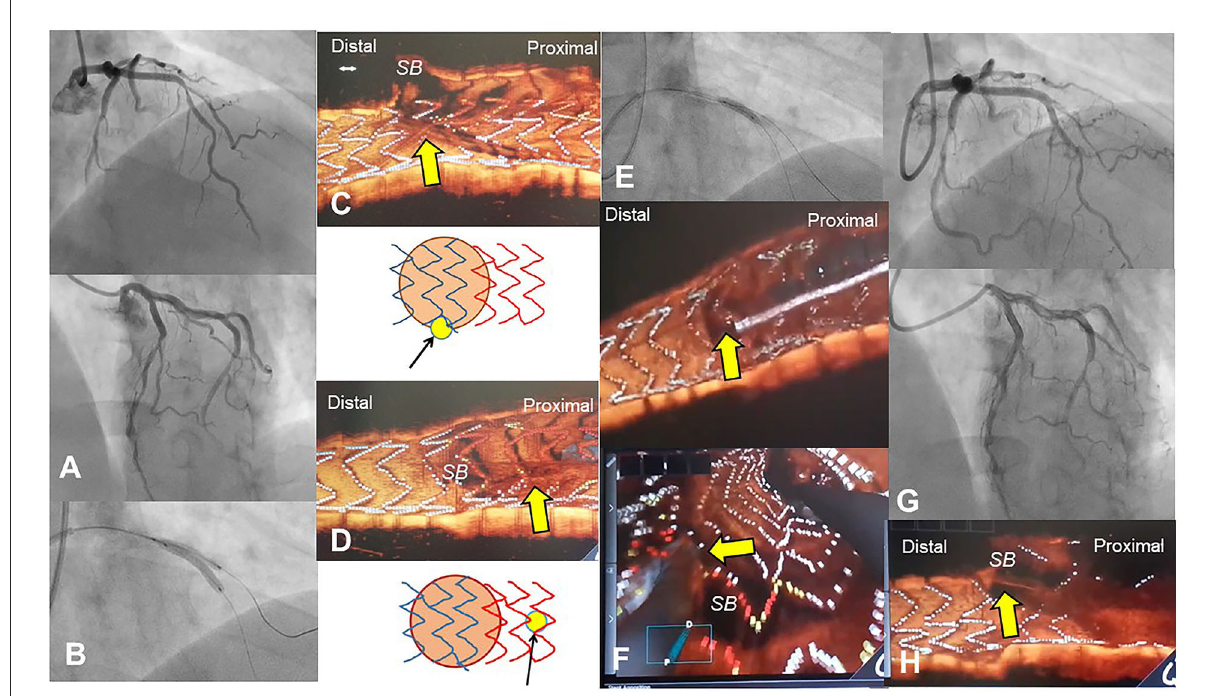
FIGURE3 Optimal guidewire recrossing using 3D optical coherence tomography (OCT) imaging after jailed balloon technique. A 55-year-old man with Medina 1-1-1 lesion in left anterior descending artery (LAD)-diagonal bifurcation (A) was treated with crossover stenting with jailed balloon technique that accompanied simultaneous dilation of a 2.75/18mm Ultimaster stent and a jailed 2.0mm balloon (B) (Supplementary Movie 4). Since the proximal part of the jailed balloon protruded in the LAD, significant stent malapposition around the ostium of the diagonal branch inhibits optimal guidewire recrossing. First guidewire recrossing is in the rim of the ostium and outside of the link connection, which was suboptimal ( C , arrow) (Supplementary Movie 5). Second guidewire recrossing is in a more proximal cell located outside of the ostium, which is also suboptimal ( D , arrow) (Supplementary Movie 5). After proximal optimization with 2.75mm balloon (E) , guidewire recrossing in the optimal distal cell is confirmed in the 3D OCT imaging ( F top: 3D vessel view, bottom: 3D fly-through view). After final kissing balloon inflation (KBI) with 2.75 and 2.0mm balloons, final coronary angiography shows acceptable results (G) (Supplementary Movie 4). The 3D OCT shows a wide opening of the diagonal branch ostium without any stent deformation or malapposition (H) (Supplementary Movie 5).